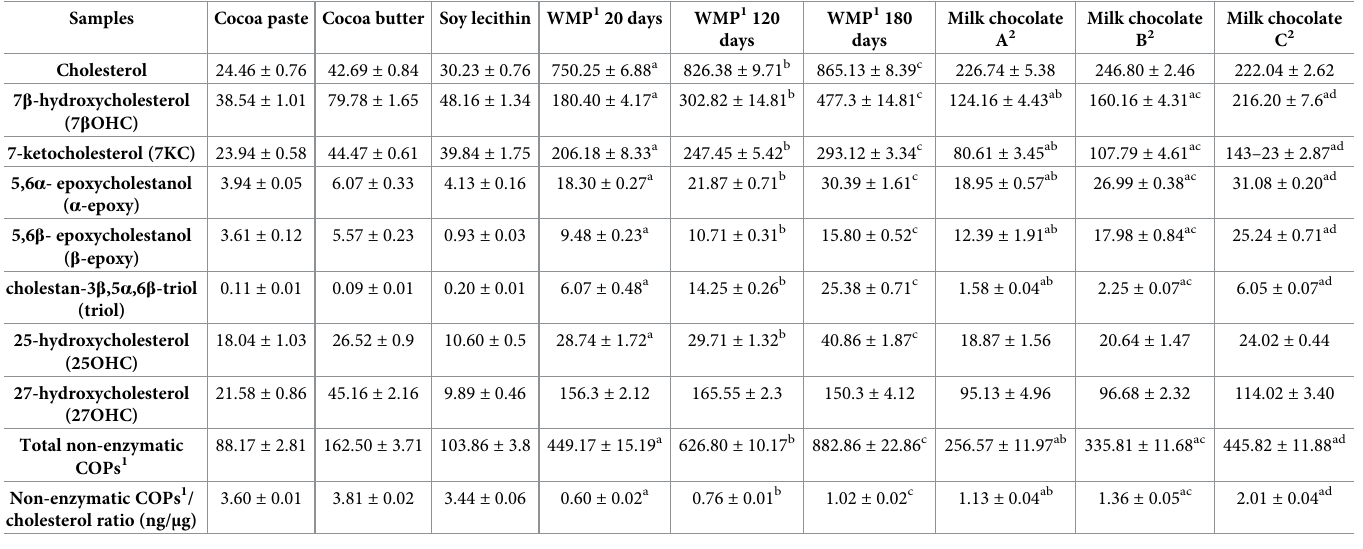
Table 2. Cholesterol ( μ g/g) and COPs (ng/g) in the three prototype milk chocolate bars and the ingredients used for their production.